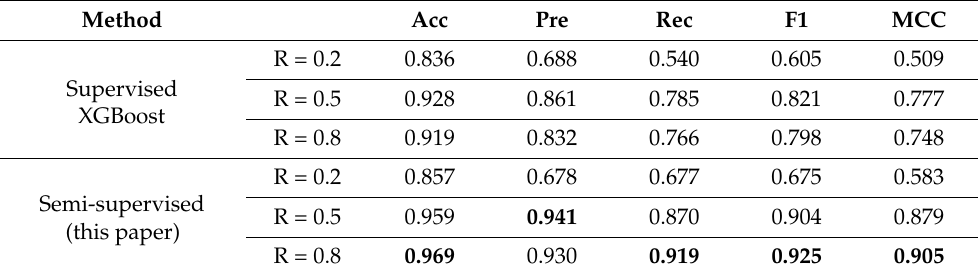
Table 3. Comparison of supervised and semi-supervised classification models.